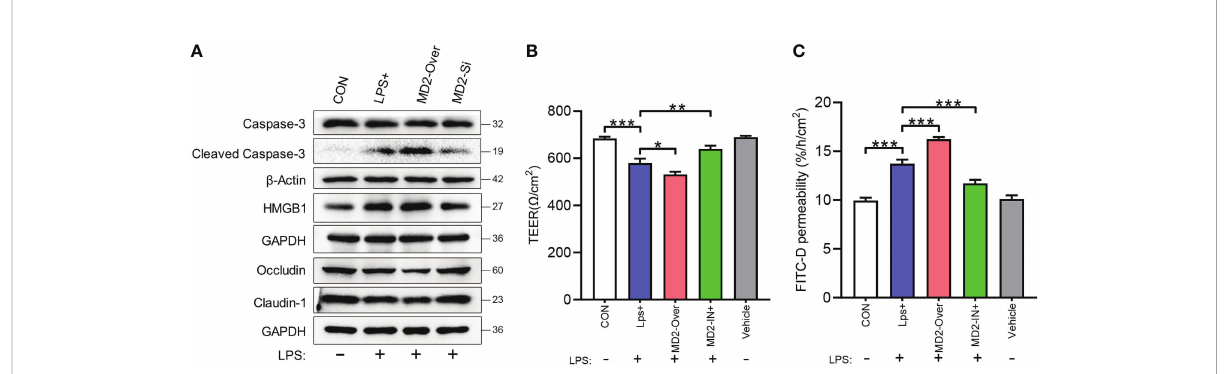
FIGURE 7 Effects of MD2 on in fl ammatory injury and barrier function in IEC-6 enterocytes. (A) The expression of HMGB1, caspase-3, cleaved caspase-3, occludin and claudin-1 was measured by western blot analysis (n=3). (B) Cell monolayer permeability was detected using TEER. (C) Determination of FITC-D permeability (n=3). LPS+, IEC-6 + LPS; MD2-Over, MD2-overexpressing IEC-6 + LPS; MD2-IN-1+, IEC-6 + MD2 inhibitor + LPS; Vehicle, IEC-6 treated with DMSO at a 1:1000 dilution. p value was analyzed by one-way ANOVA with multiple